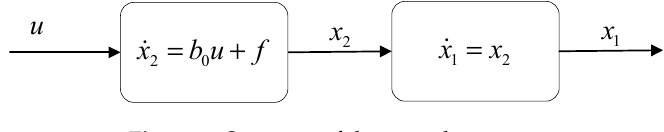
Figure 5. Structure of the cascade system.